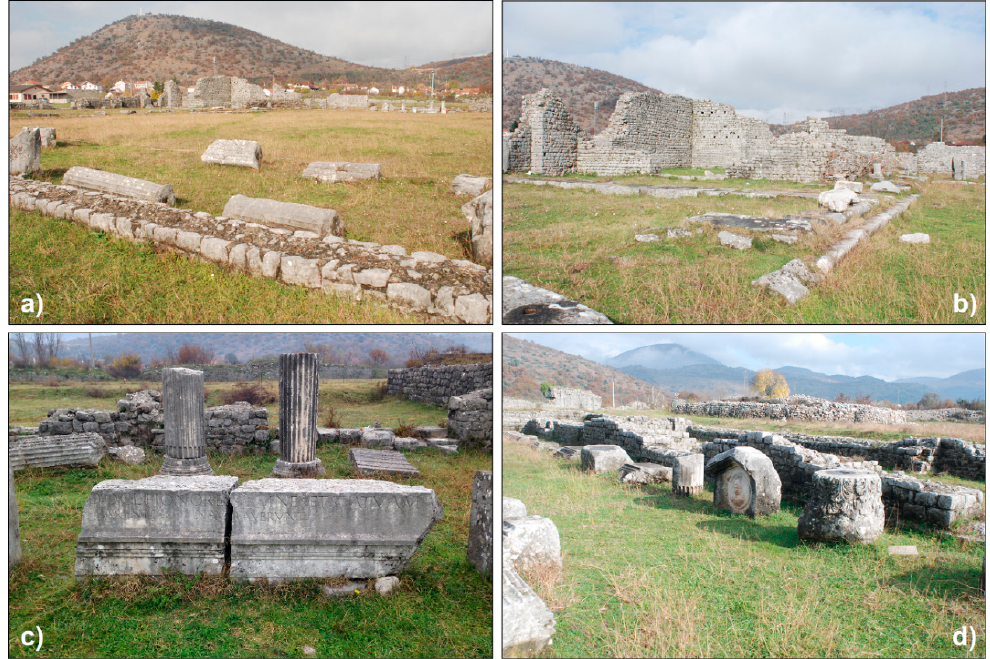
Figure 6. Doclea: the forum ( a ), the civil basilica ( b ) and some details of architectural elements ( c , d